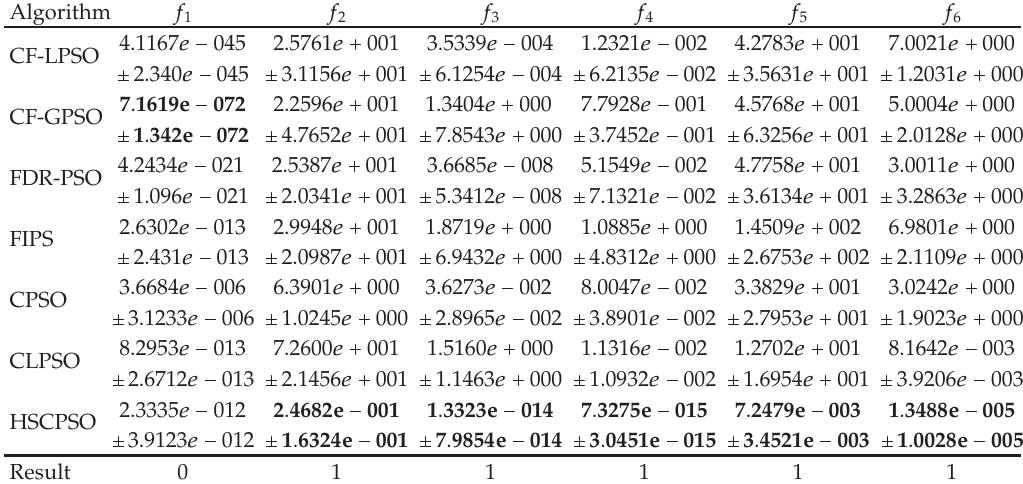
Table 4: Means after 3 10 4 function evaluations for the unrotated test functions. (cid:4)